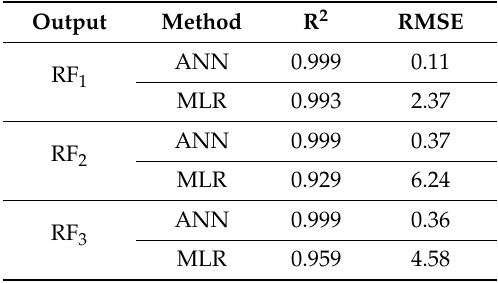
Table 5. Comparison of ANN results versus multiple linear regression (MLR).